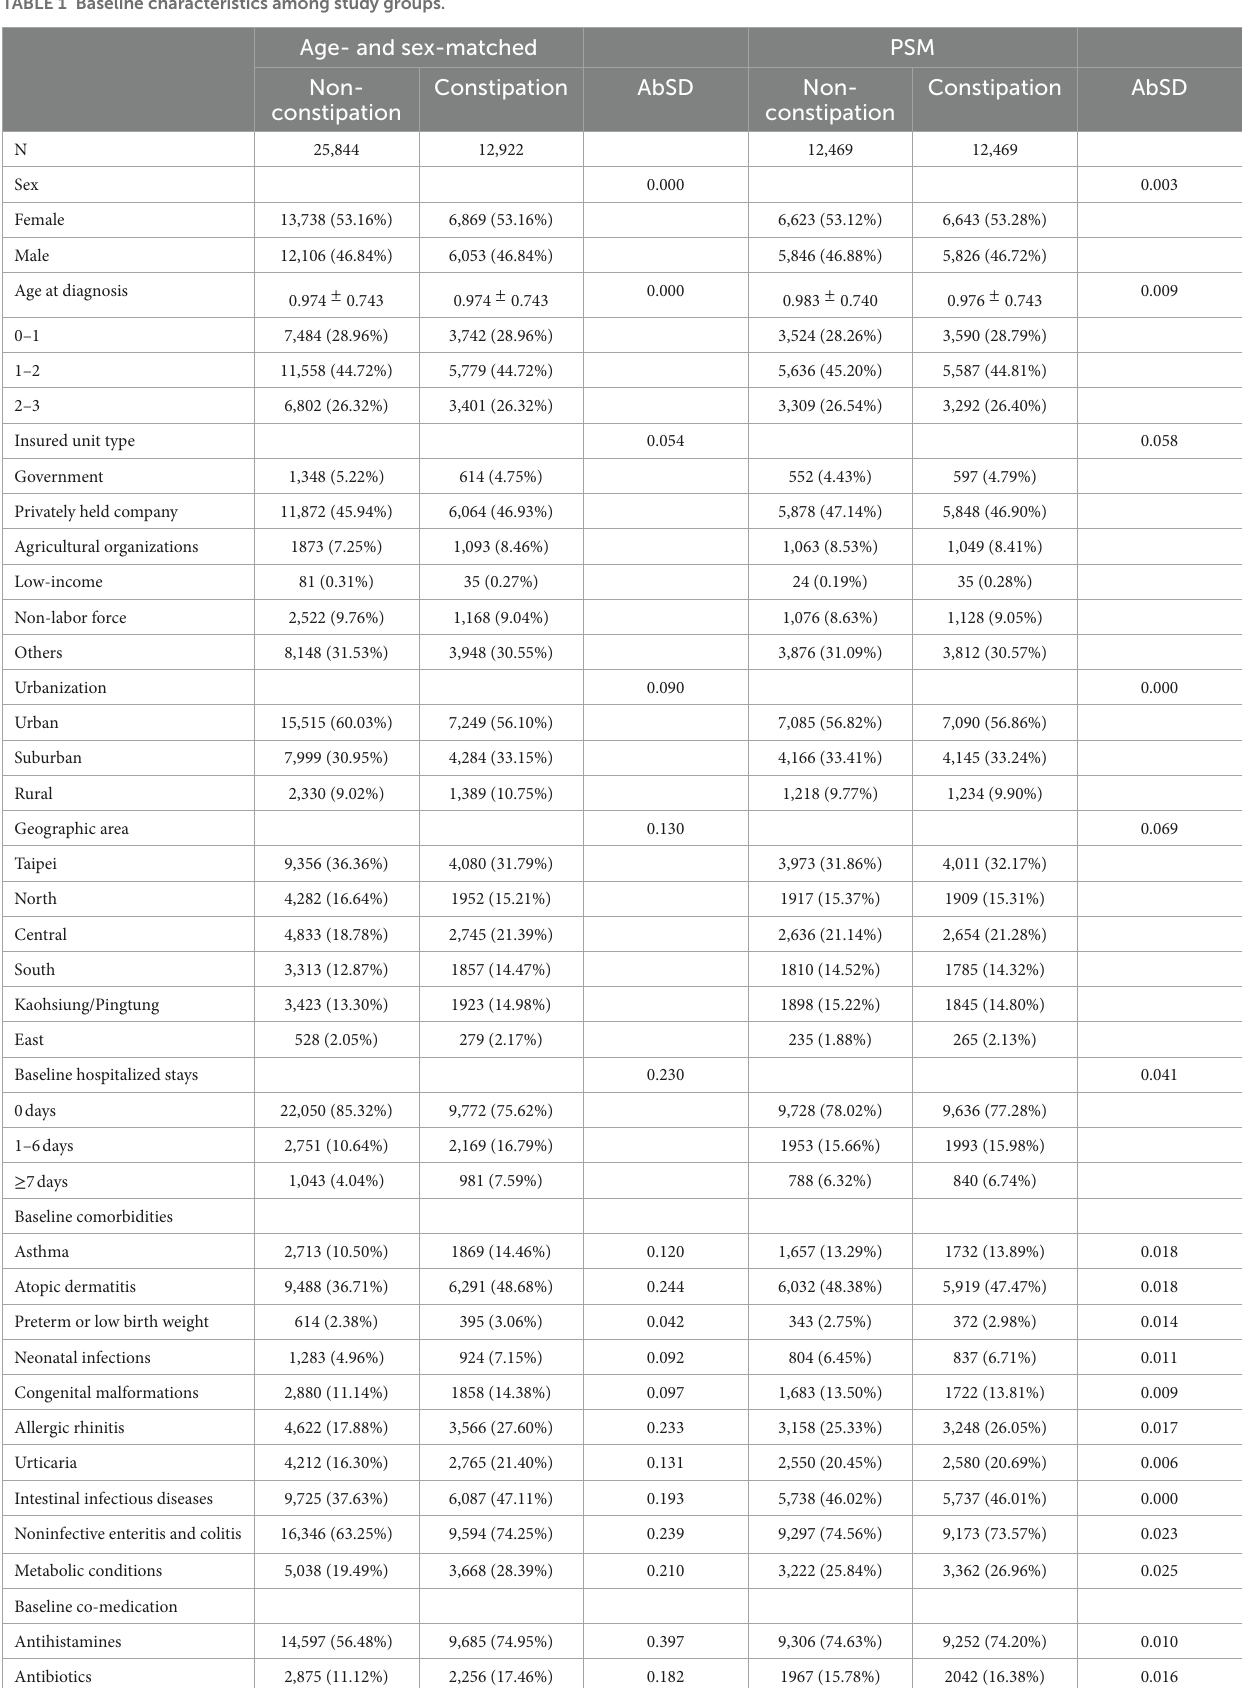
TABLE 1 Baseline characteristics among study groups. Age- and sex-matched PSM Non- Constipation AbSD Non- constipation